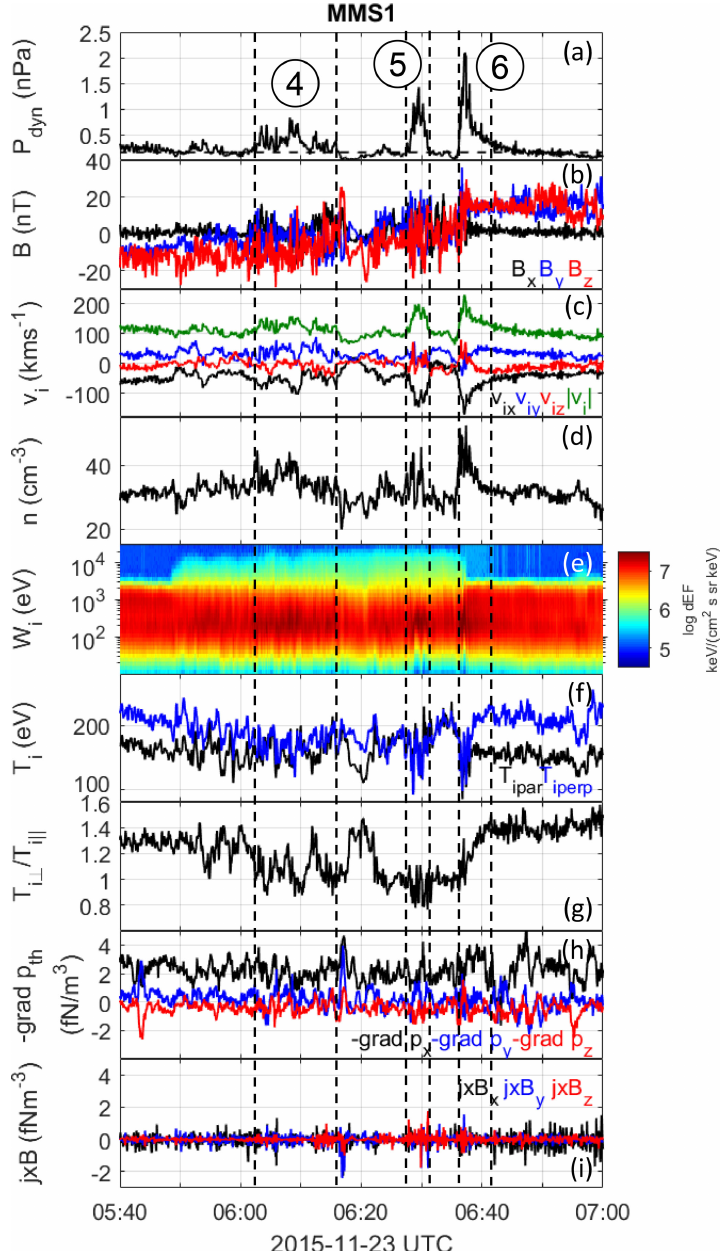
Figure 10. Overview of MMS1 measurements in the magnetosheath on 23 November 2015. From top to bottom are shown dynamic pres- sure, magnetic field B , ion velocity v i , ion and electron density ( n i and n e ), omnidirectional ion differential energy flux, ion and electron temperatures ( T i , T e ), ion temperature anisotropy ( T iperp /T ipar ), negative of the gradient of the total pressure, and the magnetic force j × B . Three localized increases in dynamic pressure have been marked as jets no.